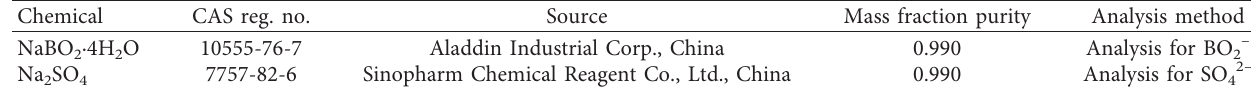
Table 1: Chemical reagents in this